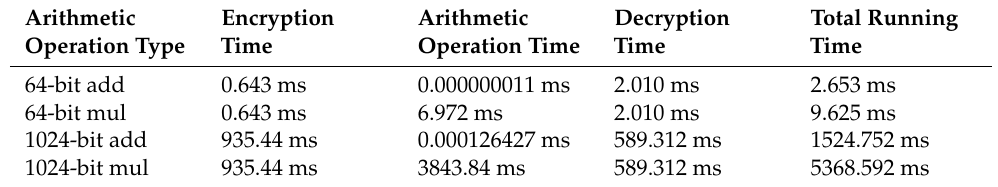
Table 4. Performance of BGV implemented in HElib library on additive and multiplicative operations.